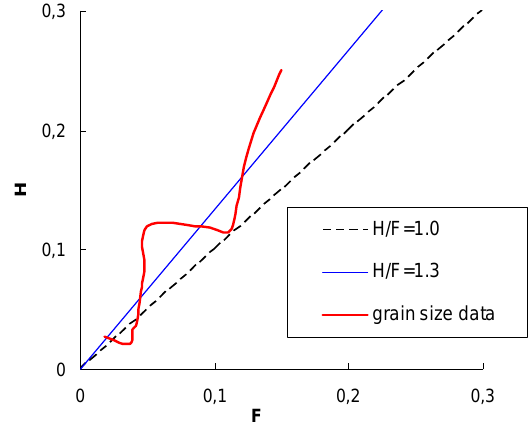
Fig. 15. Back-analysis of the slope stability of the embankment Figure 15 – Back-analysis of the slope stability of the embankment at time t = 6h. Sliding 5 at time t = 6h. Sliding surface assumed along the downstream surface assumed along the downstream slope (a) and along the upstream slope (b). The blue 6 slope (a) and along the upstream slope (b) . The blue dashed line dashed line represents the saturation level calculated at the same time. 7 represents the saturation level calculated at the same time.